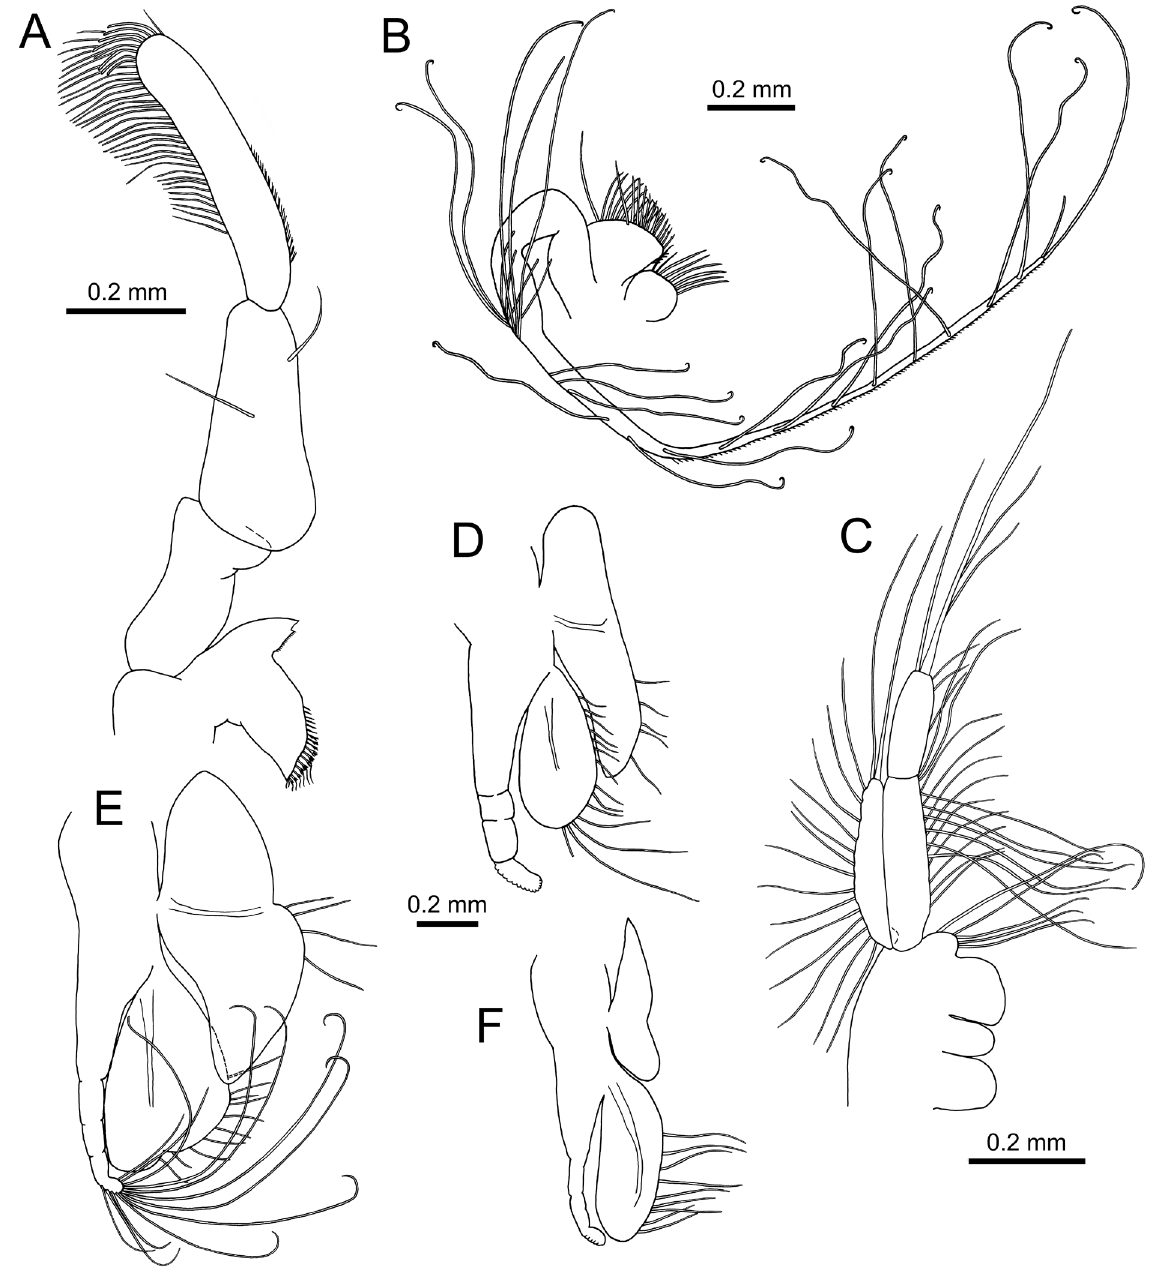
Fig. 7. Nebalia abyssicola Fage, 1929. Ovigerous female (DBUA0002350.01.A). A . Mandible. B . Maxilla I. C . Maxilla II. D . Thoracopod II. E . Thoracopod VII. F . Thoracopod VIII. C: setules and endites’ setae not illustrated; D, F: endopod distal setae not illustrated; D–F: same scale